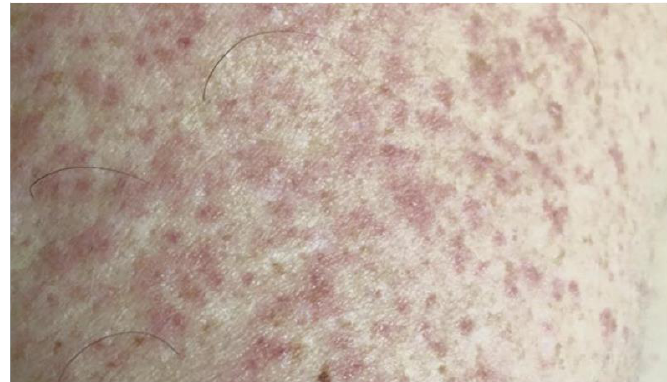
Figure 6. Rash on a patient with Zika